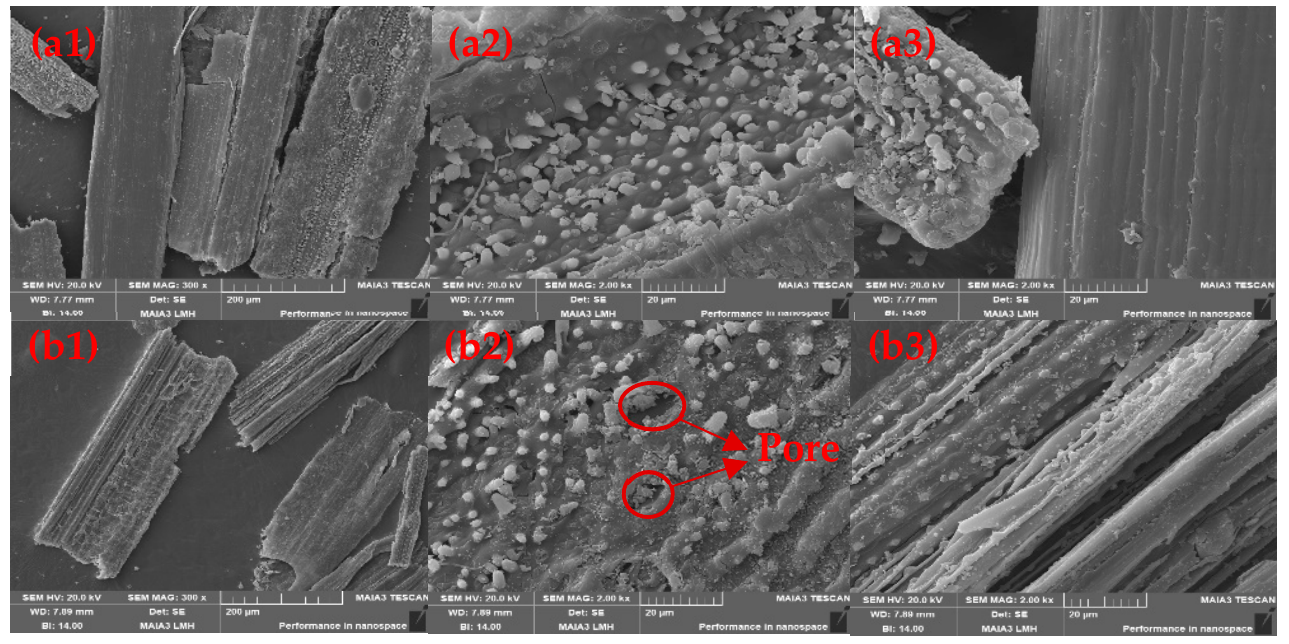
Figure 8. SEM images: ( a1 – a3 ) unmodified, ( b1 – b3 ) modified with SDS under the concentration of 2%, and reacting for 120 min at 20 ◦ C.